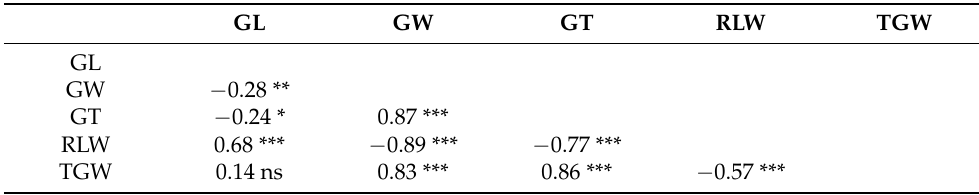
GL—grain length; GW—grain width; GT—grain thickness; RLW—the ratio of length to width; TGW—1000-grain weight; ns—not significant. Significance levels: * p < 0.05, ** p < 0.01, and *** p <